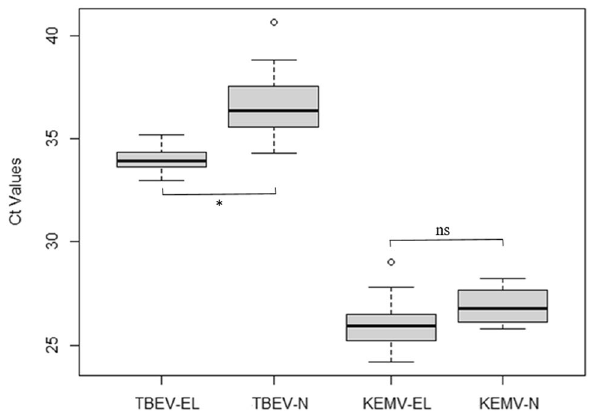
Figure 1. Detection of KEMV Seg-2 and TBEV envelope genes by real-time RT-PCR in lysates of individual Ixodes ricinus after infection using the artificial feeding system—EL: Engorged Larvae, N: nymphs (N infected at the larval stage) and comparison of mean Ct values for each group (Kruskal–Wallis test, alpha = 5%, *: p value < 0.001). The lower and upper lines represent the lower (Q1) and upper (Q3) quartiles. The median is represented in the diagram and data falling outside the Q1-Q3 range are plotted as outliers of the data